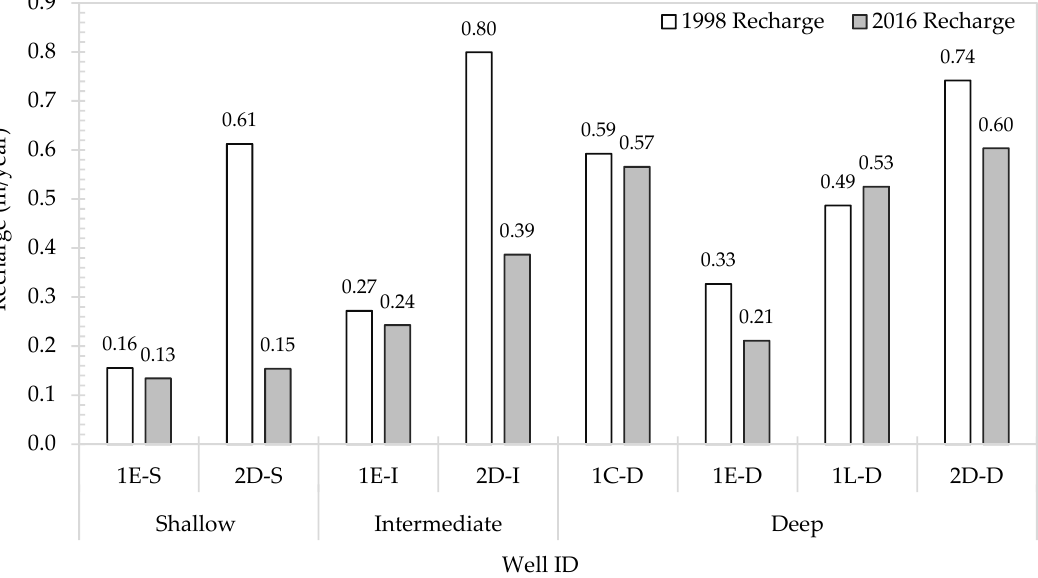
Figure 3. Comparison of 1998 and 2016 recharge rates categorized by shallow, intermediate, and deep well depths.